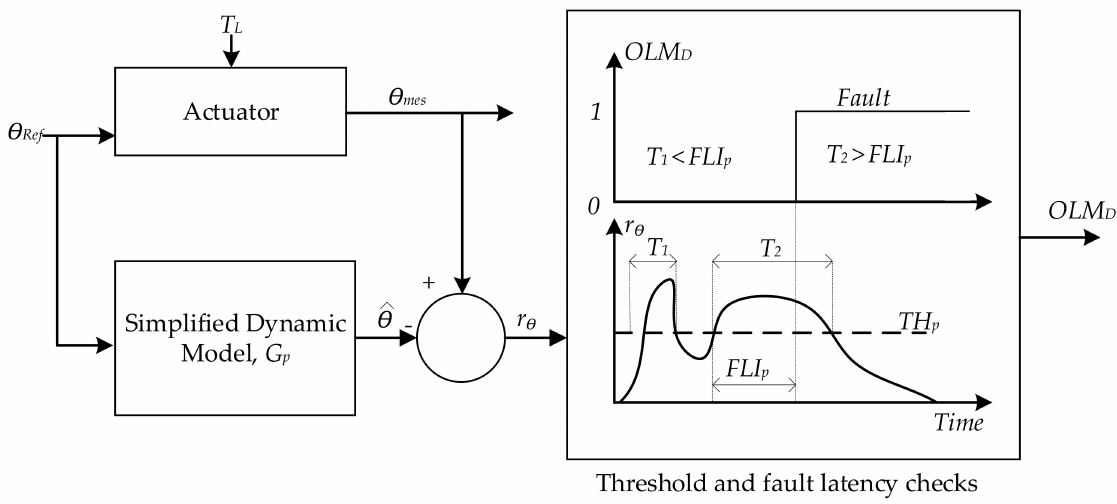
Figure 16. The principle of an OLM